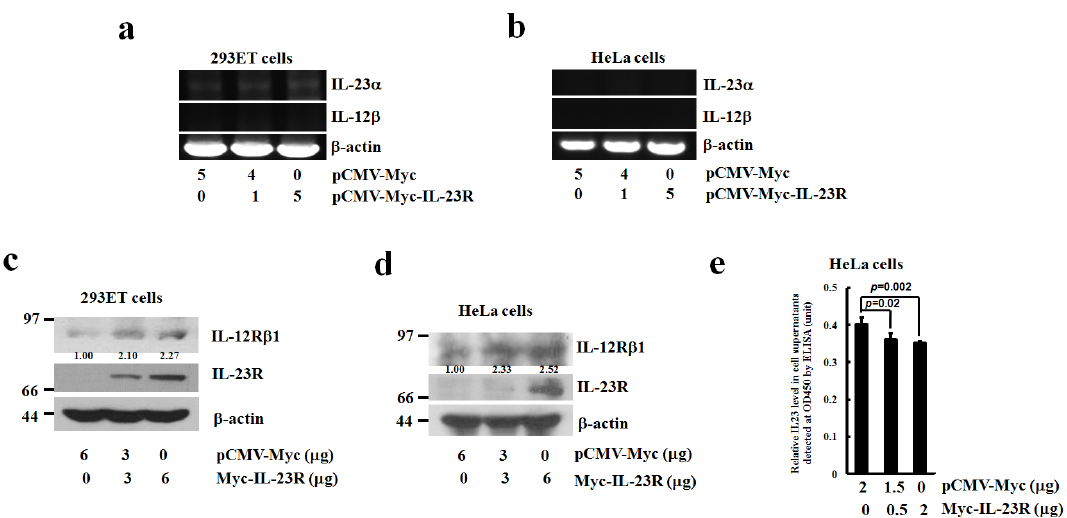
Figure 8. The expression levels of endogenous IL-23 α , IL-12 β and IL-12R β 1 in responding to the overexpression of IL-23R. Semi-quantitative RT-PCR analysis was performed to detect the endogenous IL-23 α and IL-12 β expressions in both 293ET ( a ) and HeLa cells ( b ) in responding to exogenous delivery of IL-23R; the expression levels of endogenous IL-12R β 1 were detected by western blot analysis on IL-23R transfected 293ET ( c ) and HeLa cells ( d ). The data is the representative of at least two independent transfection assays. The expression of β -actin was served as an internal control. The relative intensities of individual bands were calculated based on the expression of β -actin by using the Quantity One program; and ( e ) Detection of IL-23 production in HeLa cell supernatants in responding to IL-23R delivery by Enzyme Linked Immunosorbent Assay (ELISA). After 48 h transfection, the cell supernatants were collected from a 12 well plate and subjected to standard ELISA analysis. The reaction products were detected at 450 nm using a microtiter plate reader. Each value is represented as mean ± SD from four independent transfections. Statistic analysis was performed with student’s t test. Statistical difference was considered to be significant if p <